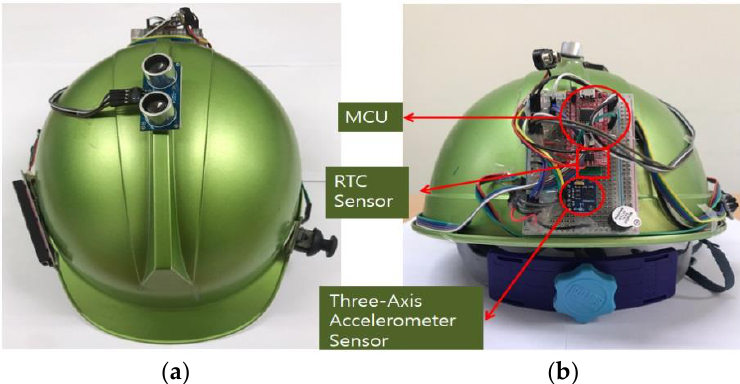
Figure 6. Prototype of three-axis accelerometer sensing safety helmet: ( a ) Front side of the Safety Helmet; ( b ) Back side of the Safety Helmet.